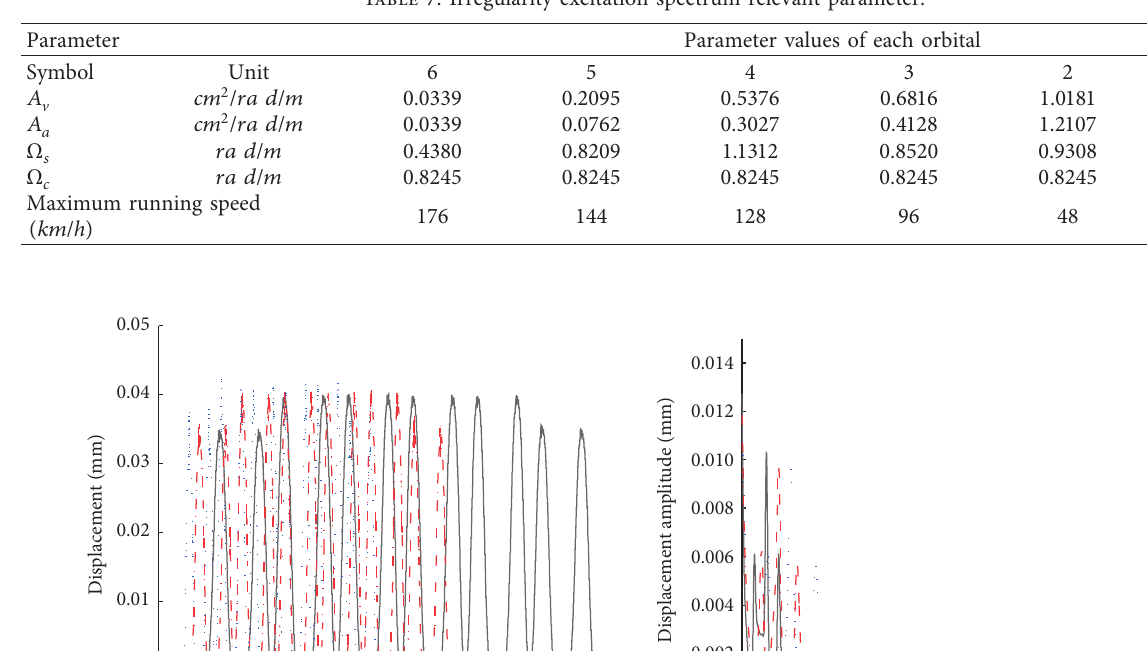
Table 7: Irregularity excitation spectrum relevant parameter.